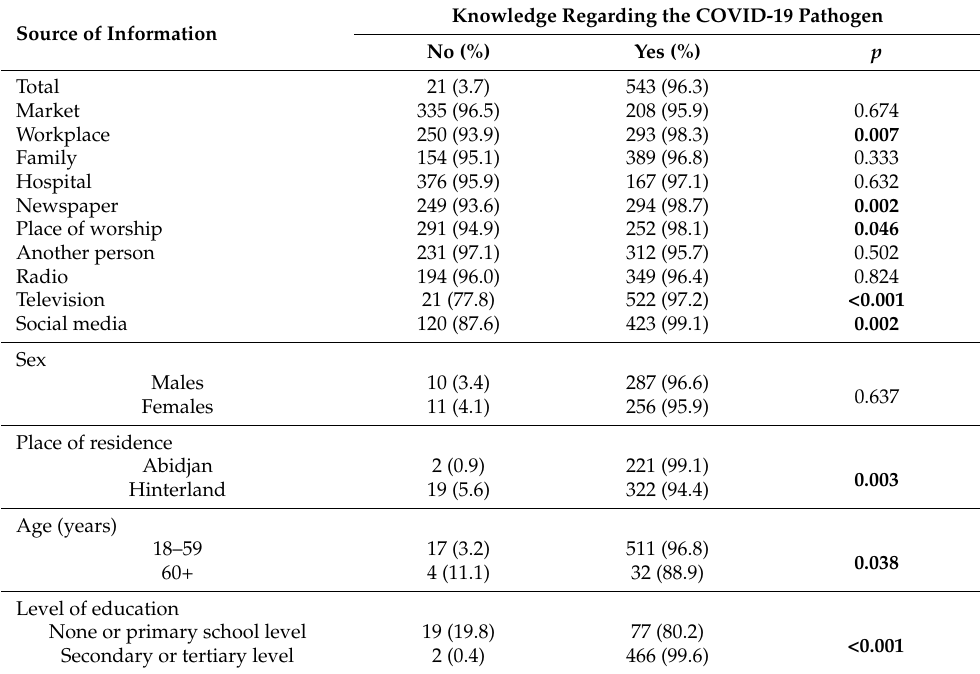
Table 1. Knowledge regarding the COVID-19 pathogen according to sources of information and socio-demographic characteristics of the